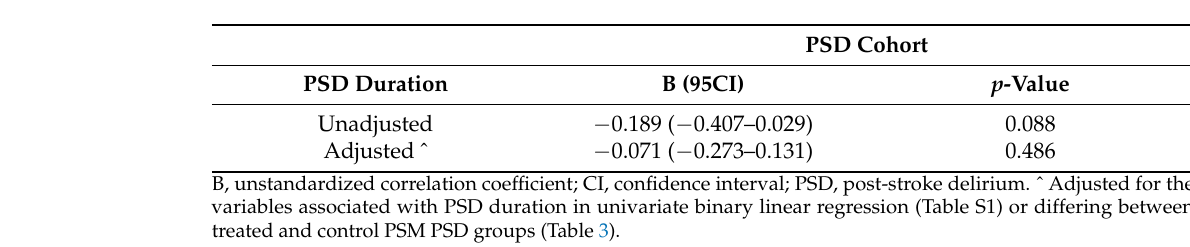
Table 4. Effect of melatonin administration on PSD